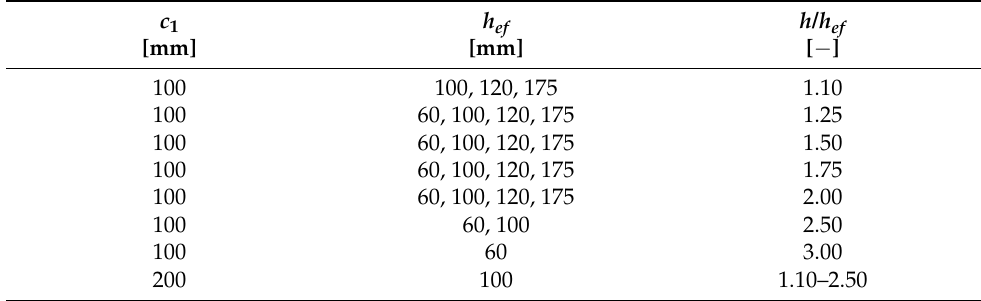
Table 5. Simulation program—influence of member thickness.